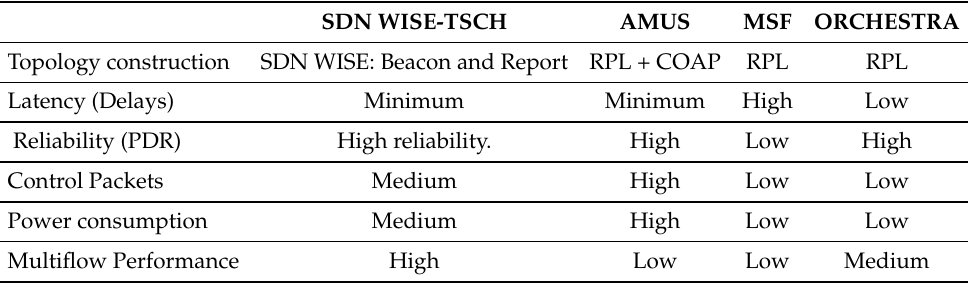
Table 3. Summary of results with the different TSCH